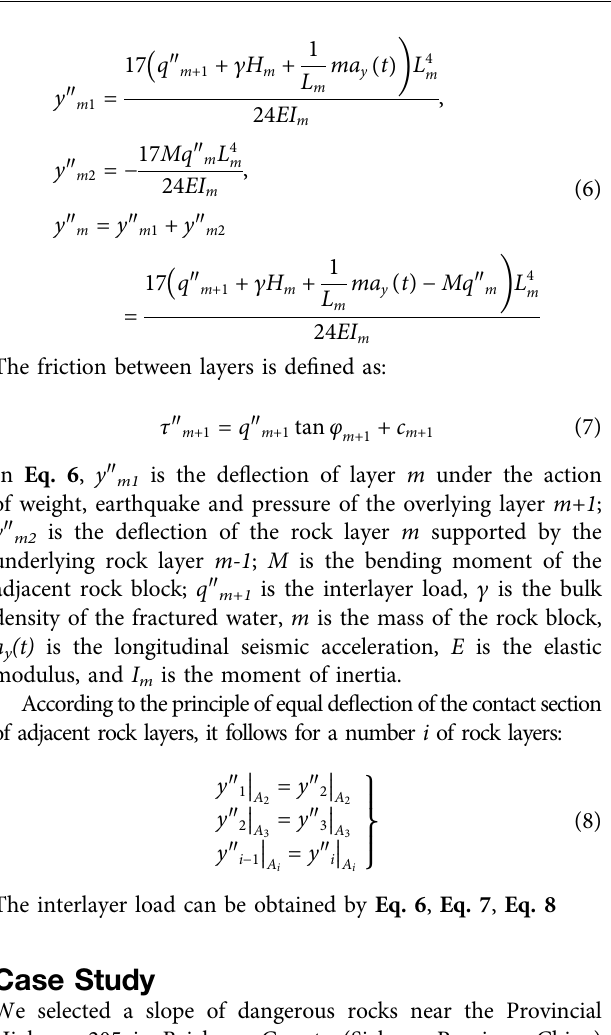
FIGURE 5 | (A) Photograph of the studied slope at the Provincial Highway 205 and (B) geometry of model four slope.